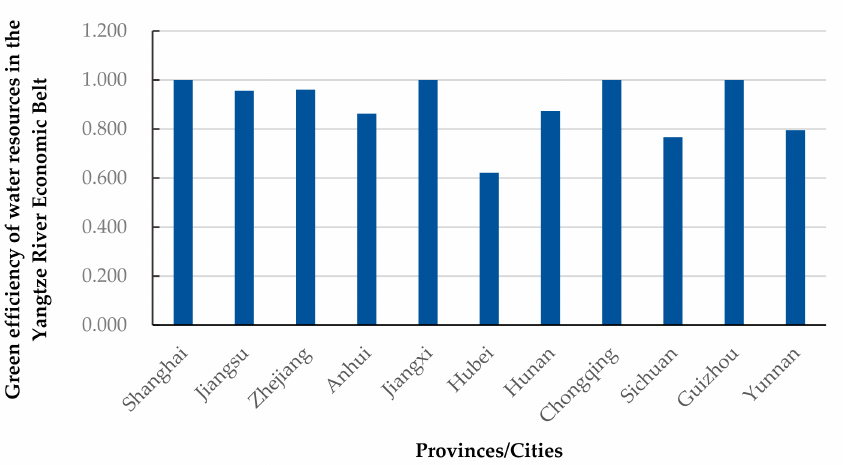
Figure 3. Green efficiency of water resources in 11 provinces and cities in the Yangtze River Eco- nomic